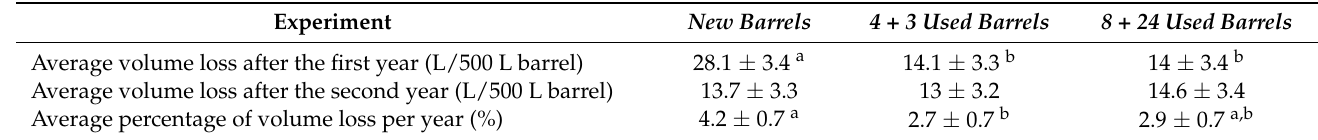
Table 4. Brandy volume loss after two years of